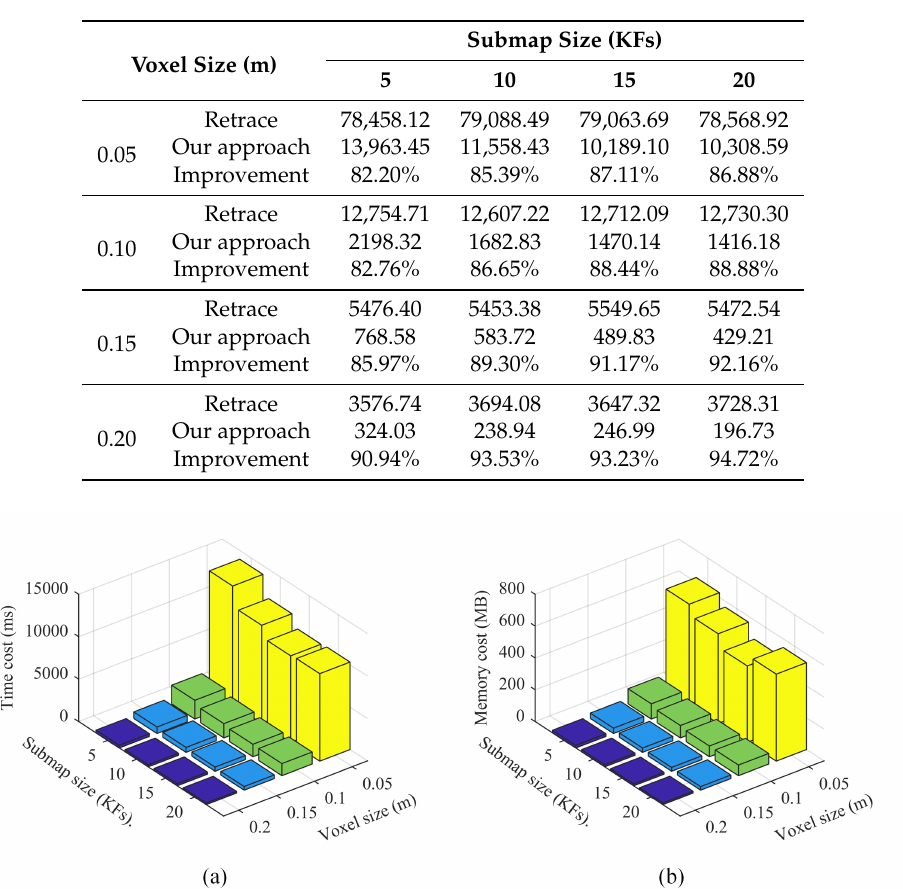
Table 2. Time costs of the retrace approach and our method with various voxel sizes and submap size (ms).